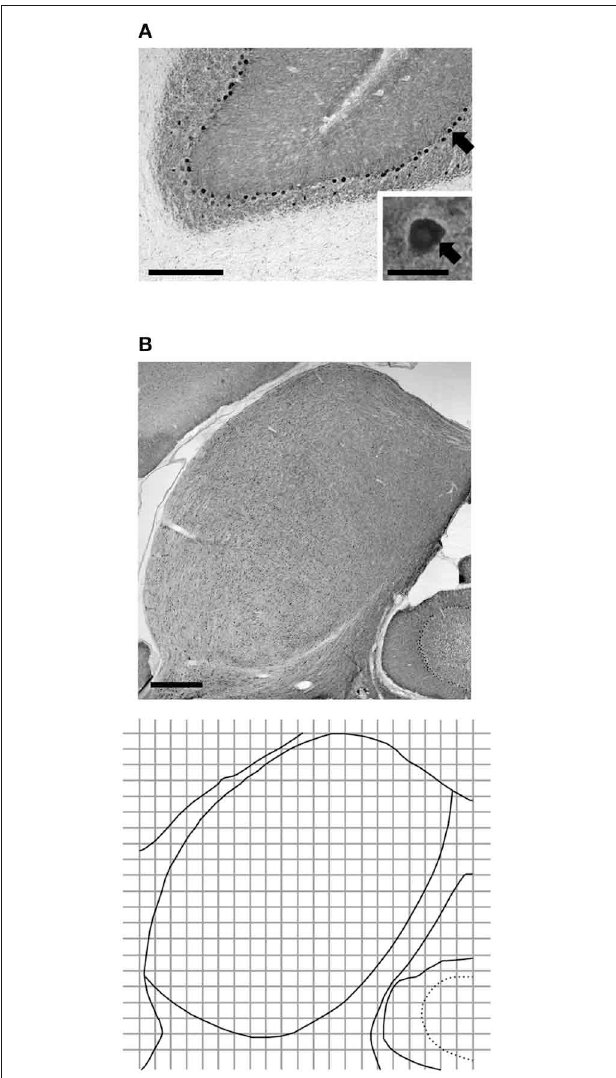
FIGURE 2 | Immunoreactivity to the antibody against the GABA B R1 subunit in the cerebellum (A) and the IC (B) as revealed by immunohistochemistry. The cerebellar section shows molecular, Purkinje cell, and granule cell layers, and white matter. Inset in (A) shows a labeled somata of a Purkinje cell, as well as adjacent areas in the molecular and granule layers. Arrow points toward the labeled Purkinje cell. The diagram in the bottom panel of (B) is the outline of the section shown in the top panel of (B) along with a grid used in the measurement of cell body and neuropil immunoreactivity. The grid was also used in the measurement of morphological features of immunoreactive cells. Each grid box has 150 × 150 μ m dimensions. Scale bars in (A) and (B) : 500 μ m in low magnification image; 25 μ m in the